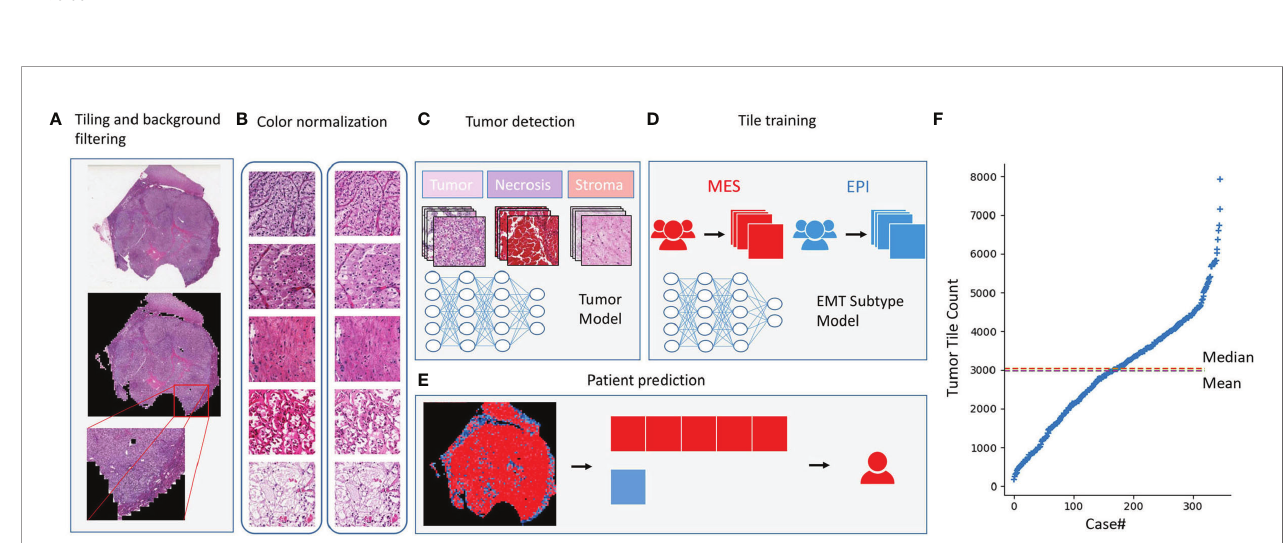
FIGURE 2 | Deep learning model. Deep learning model. (A) The whole-slide images were tiled into 256×256-pixel tiles and dropped the tiles with low amount of information while tiling. (B) Tiles before and after color normalization. (C) The convolutional neural network was trained as a tumor detector at tile level. (D) The model training for EMT subtype classi fi cation at tile level. (E) EMT subtype prediction at patient level. (F) Distribution of the number of tiles generated per case.